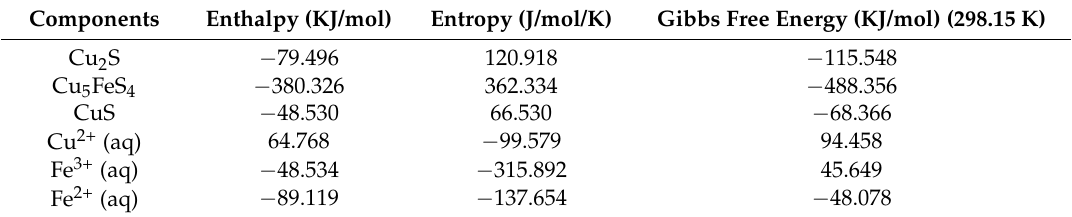
Table 3. Some standard thermodynamic data (298.15 K)